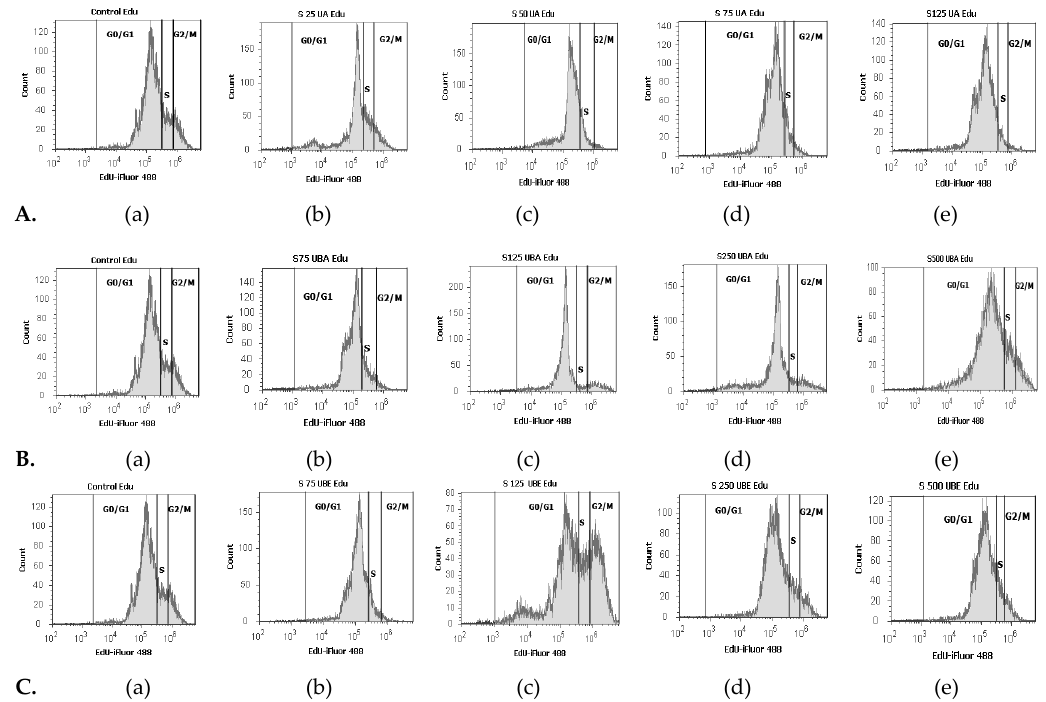
Figure 13. Cell proliferation status of UA, UBA, and UBE treatments in normal blood cell cultures. EdU-iFluor 488 patterns of UA 25, 50, 75, 125 μ g/mL ( A ( b – e )); ( B ( b – e )) UBA 75, 125, 250, 500 μ g/mL; ( C ( b – e )) UBE 75, 125, 250, 500 μ g/mL reported to 1% DMSO ( A ( a ), B ( a ), C ( a )).